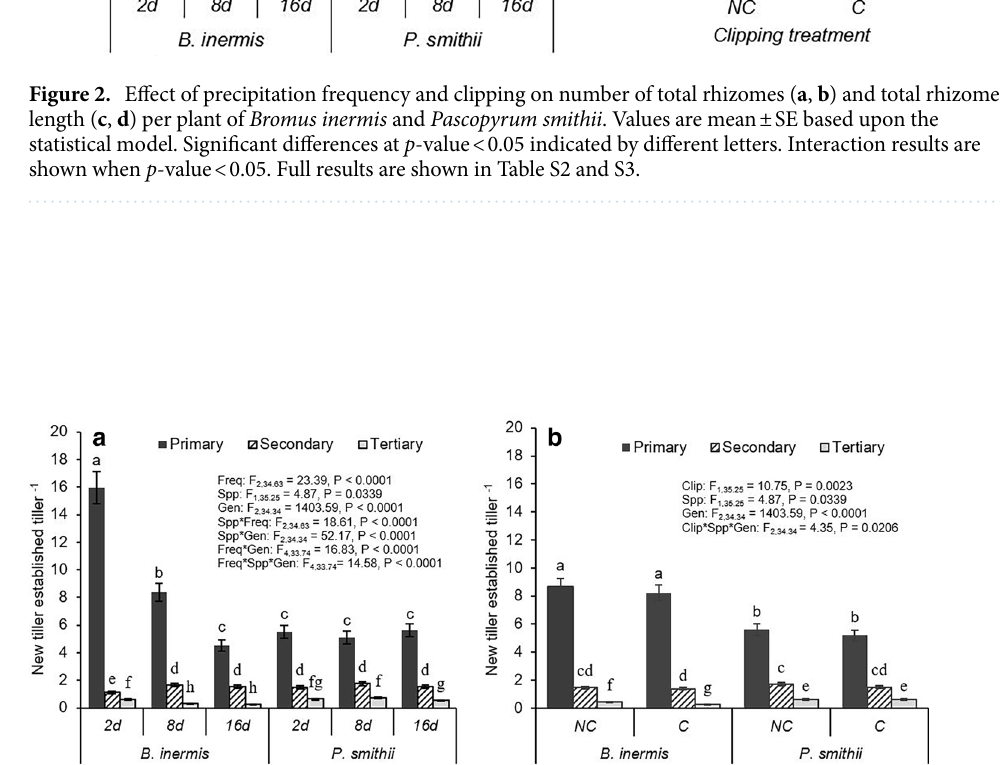
Figure 3. Effect of ( a ) precipitation frequency and ( b ) clipping on number of new tillers established per tiller of Bromus inermis and Pascopyrum smithii . We had three daughter tiller generation cohorts defined as primary, secondary, and tertiary tiller generation (see Fig. 1 for conceptual diagram). Significant differences at p -value < 0.05 indicated by different letters. Interaction results are shown when p -value < 0.05. Full results are shown in Table